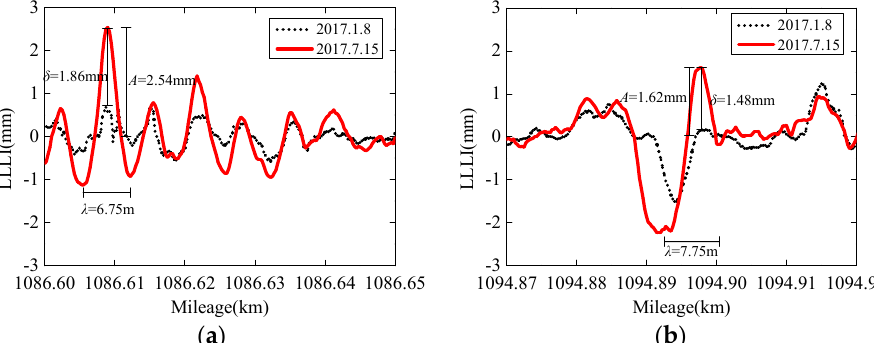
Figure 6. Several arching segments of 15 July 2017 taking the data 8 January 2017 as reference. ( a ) The segment between K1086 + 600 and K1086 + 650; ( b ) The segment between K1094 + 870 and K1094 + 920.